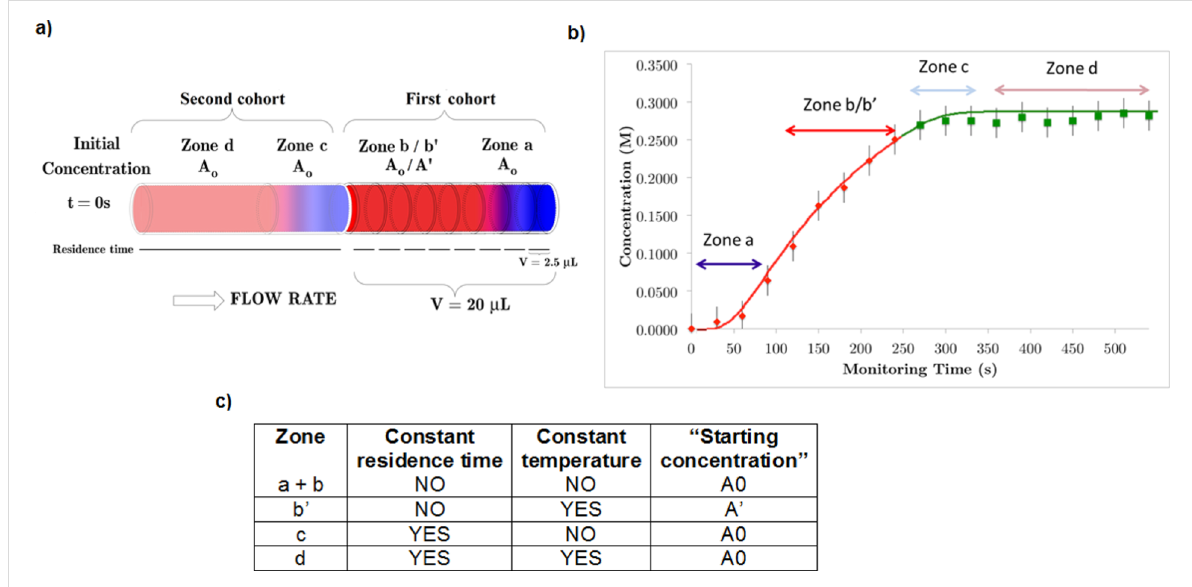
Figure 13: (a) Schematics of two microreactor cohorts of sample fractions. (b) Reaction product concentration (M) versus monitoring time (s) for the synthesis of 5-methyl-3-phenylisoxazole in methanol at an overall flow rate of 5 μ L/min (initial concentration, 0.35 M). Every data point corresponds to a 2.5 μ L fraction. (c) Table with differences between the zones (a + b, b', c, d) in residence time, temperature, and concentration. Flow-NMR analysis were performed in a 400 MHz instrument. Reproduced with permission from reference [49]. Copyright 2015 The American Chemical Society.